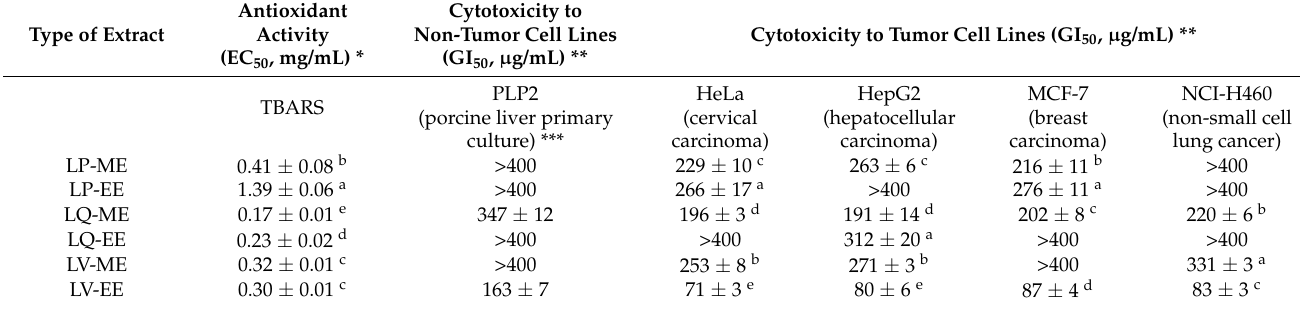
Table 6. Antioxidant and cytotoxic activities of the different Lactarius extracts (GI 50 ( µ g/mL) ±